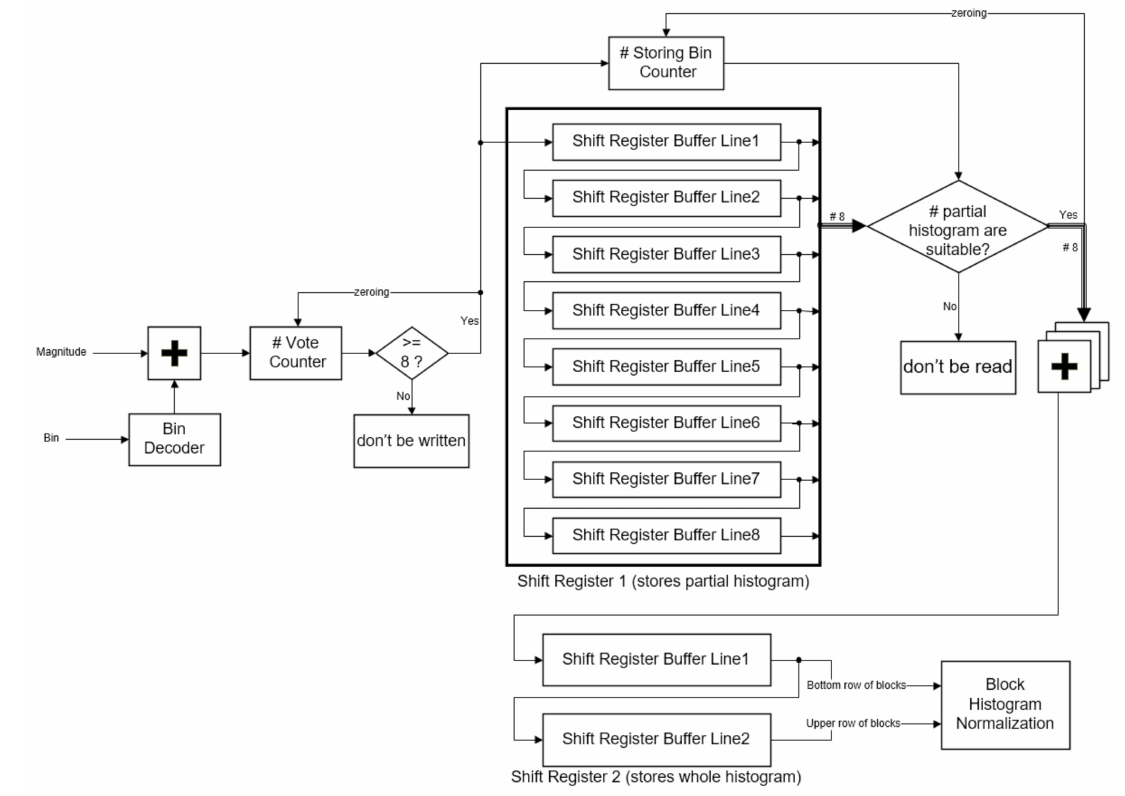
Figure 5. Diagram of the Cell Histogram Generation sub-module in the proposed